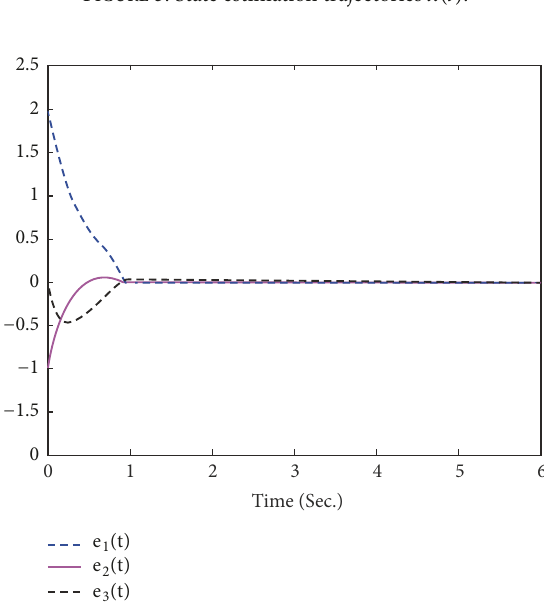
Figure 1: Trajectory of 𝑟(𝑡) .